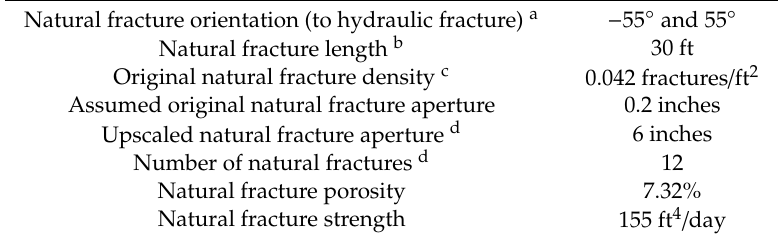
Table 2. Natural fracture data from HFTS used for model simulations.